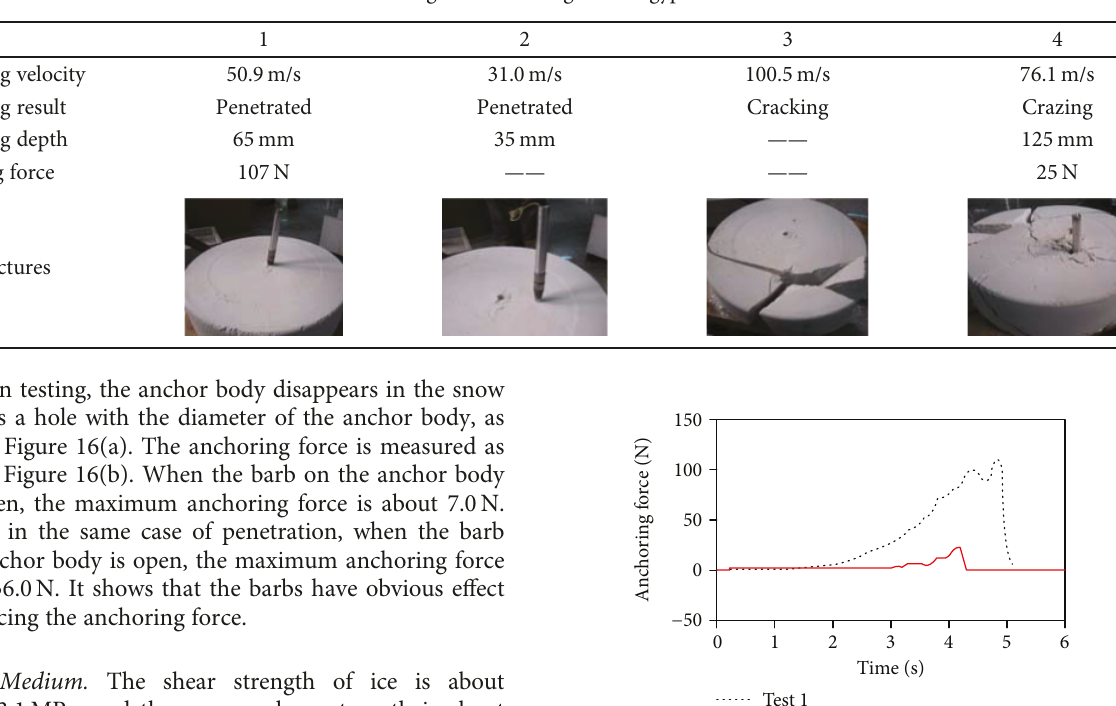
Figure 17: Penetration and anchoring tests in ice medium. Table 2: Penetrating and anchoring tests in gypsum medium.